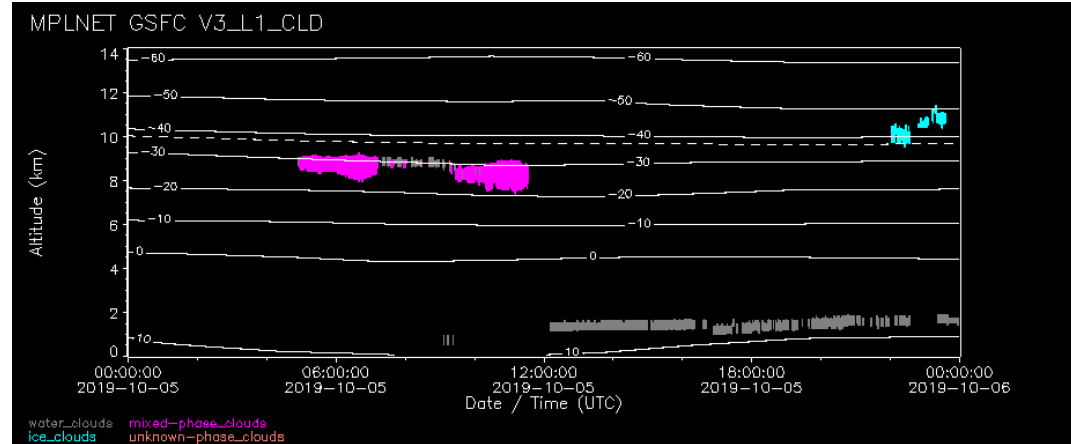
Figure 5. Example of the cloud thermodynamic phase retrieval at GSFC on 5 October 2019. The phase mask indicates liquid water clouds (grey), mixed-phase clouds (magenta), ice clouds (cyan), and unknown phase (pink). The GEOS-5 temperature is shown by the contour lines (in 10 ◦ C intervals). The − 37 ◦ C isotherm is indicated by the dashed contour line.